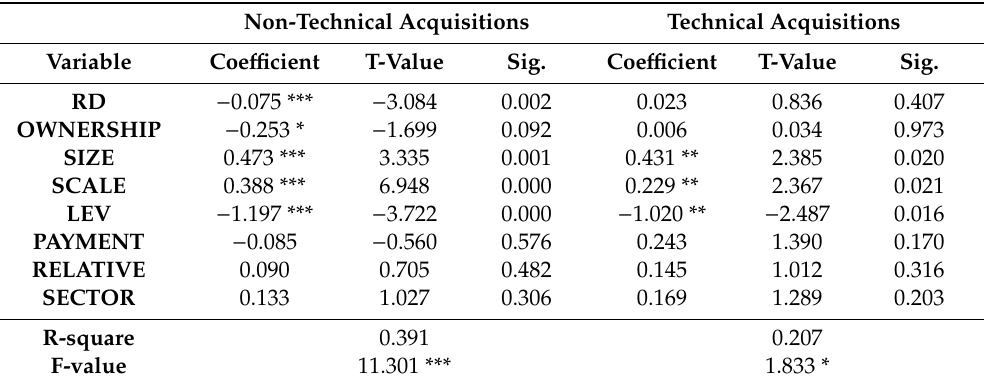
Table 6. Regression results of Model